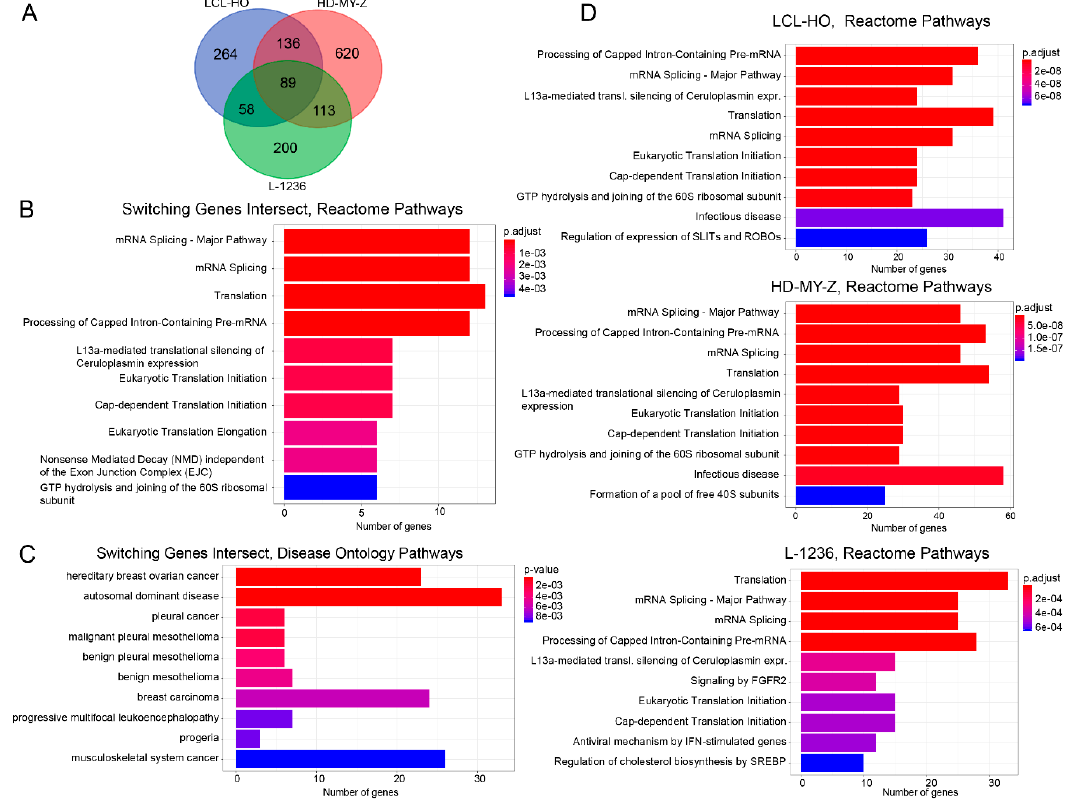
Figure 3. A core set of genes with switches between isoform expression over time is common to the cell lines analysed ( A ) We detected an intersection of 89 genes for the three cell lines, for the genes for which switching in isoform expression was detected in our analysis. ( B ) The top enriched pathways for the 89 genes are mRNA splicing and translation, as well as the processing of capped intron-containing pre-mRNA. ( C ) All but one of the top 10 enriched disease ontology terms associated with the 89 genes are different forms of cancer. ( D ) We analysed all genes for which switches in isoform expression over time were detected for the three cell lines. A set of common pathways including mRNA splicing, translation and ribosomal activity was identified for all cell lines, the L-1236 cell line shows an additional enrichment for the FGFR2 pathway.